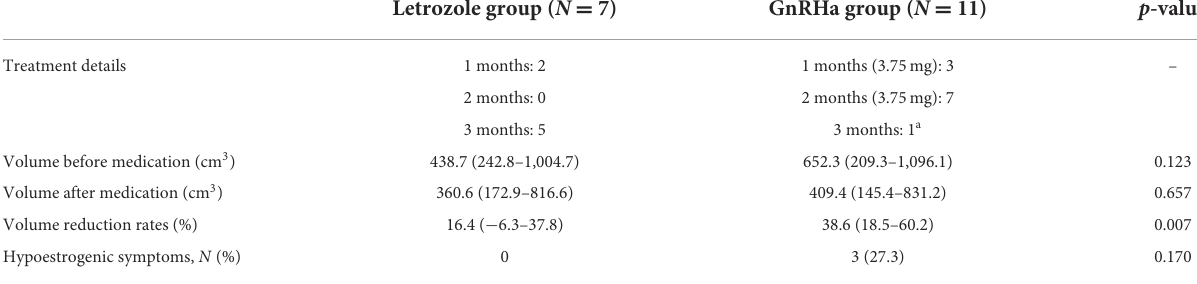
TABLE 2 Pre-HIFU medical treatment